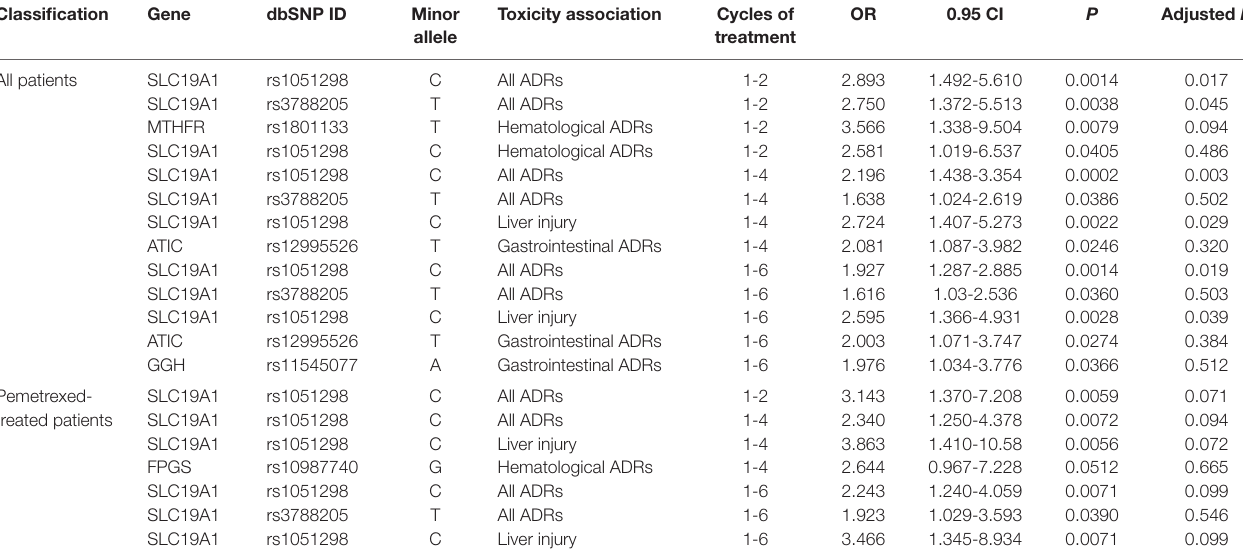
TABLE 2 | Summary of association analysis of SNP site and ADRs results. Classification